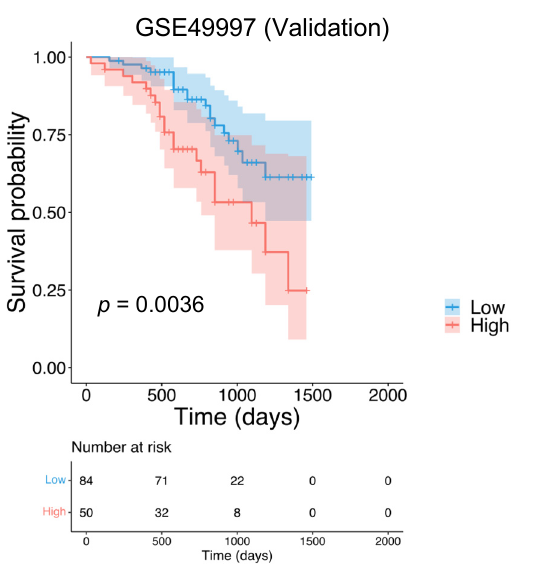
Figure 2. Identification of the HGSOC Tumor Matrisome Index (HGSOC-TMI) and its prognostic ability. Kaplan–Meier plots for the high-grade serous ovarian carcinoma (HGSOC) in the case of ( A ) the discovery set OV-TCGA (N = 341) and the following validation sets: ( B ) GSE26712 (N = 185) and ( C ) GSE49997 (N = 134).